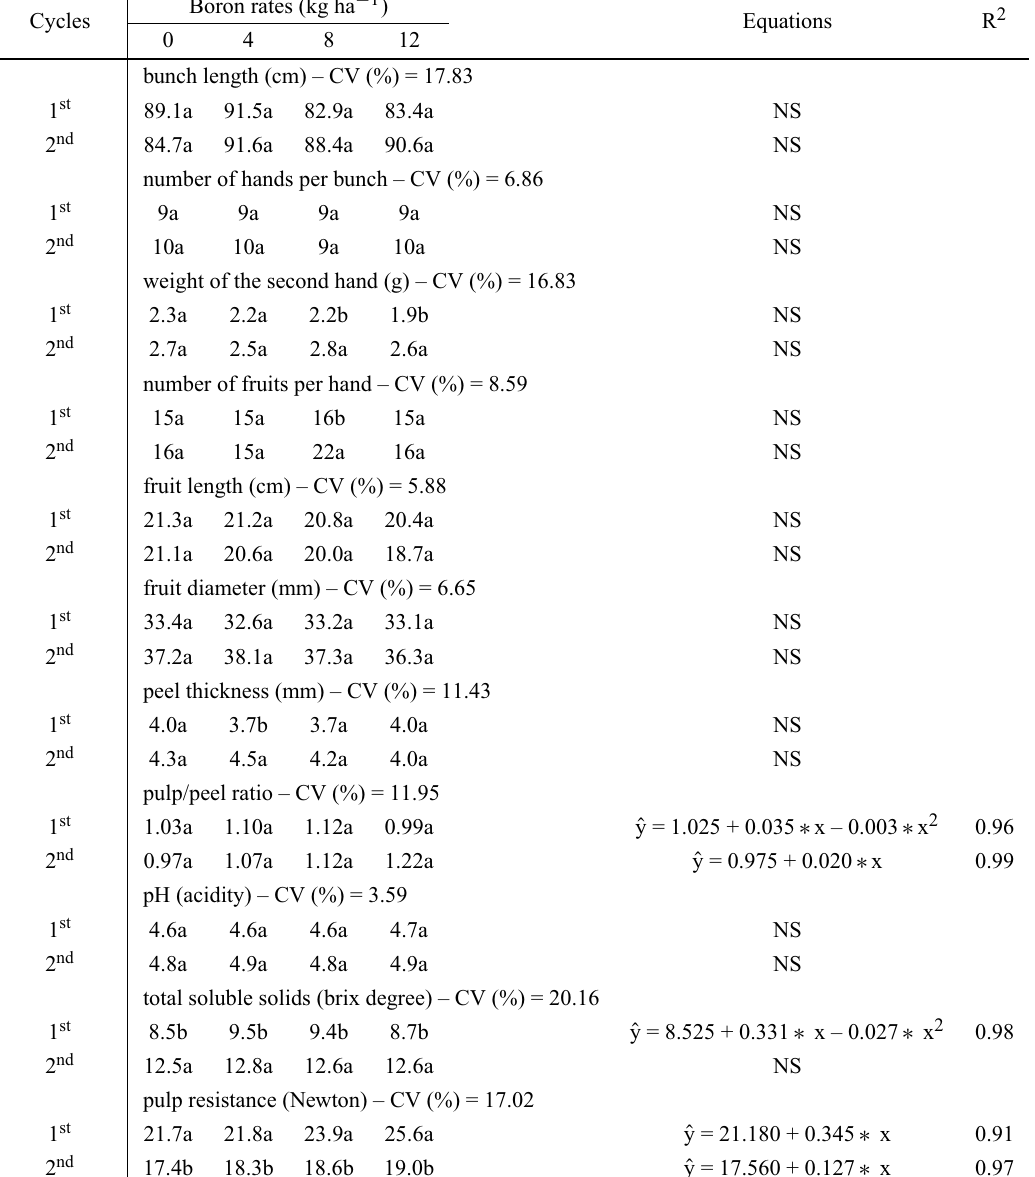
( 1 ) . Equations R 2